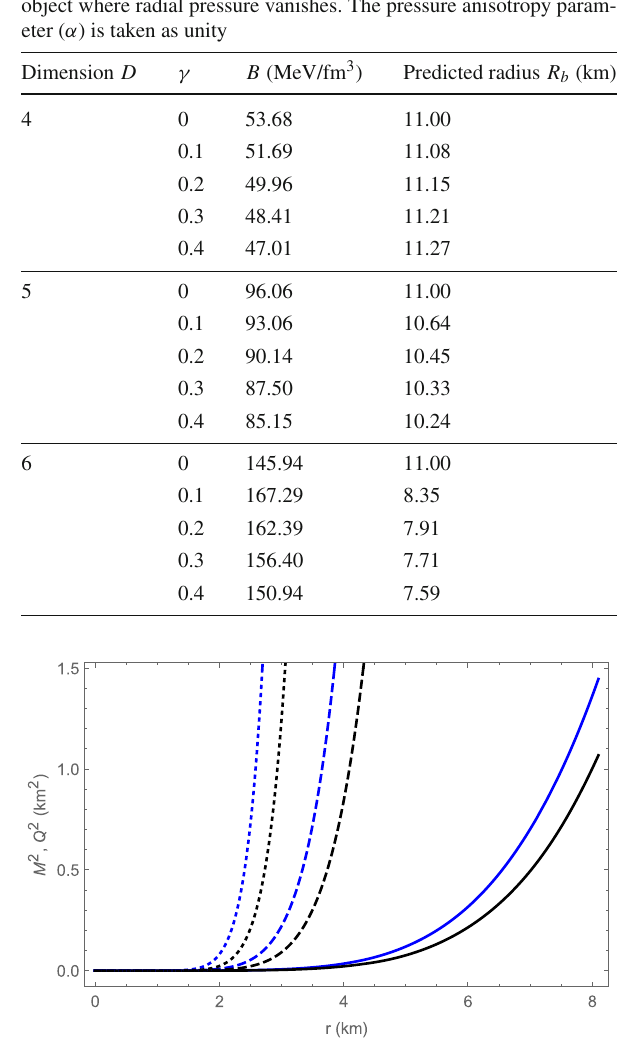
Fig. 23 Radial variation of M 2 and Q 2 inside HER X-1. Here blue and black curves correspond to plots of M 2 and Q 2 respectively. Solid, dashed and dotted curves correspond to D = 4, D = 5 and D = 6 respectively. To obtain these plots we have considered pressure isotropy condition and set γ = 0 . 4